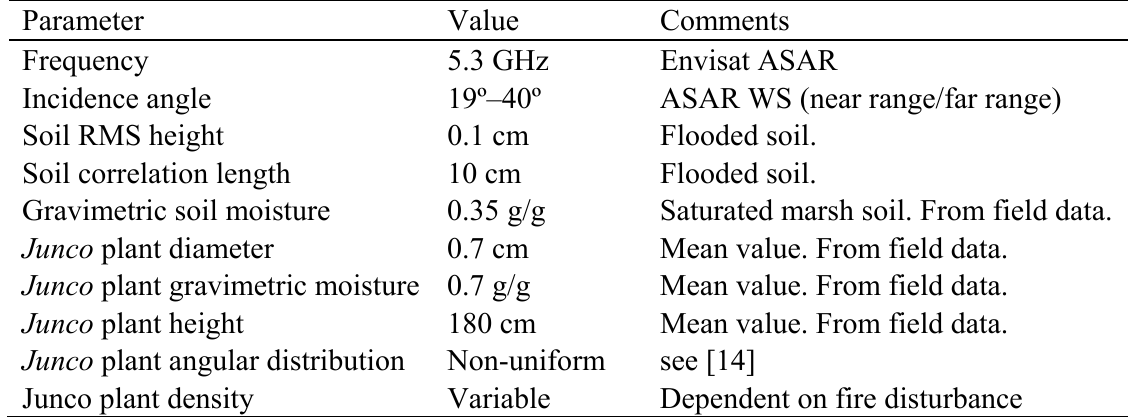
Table 2. Model input